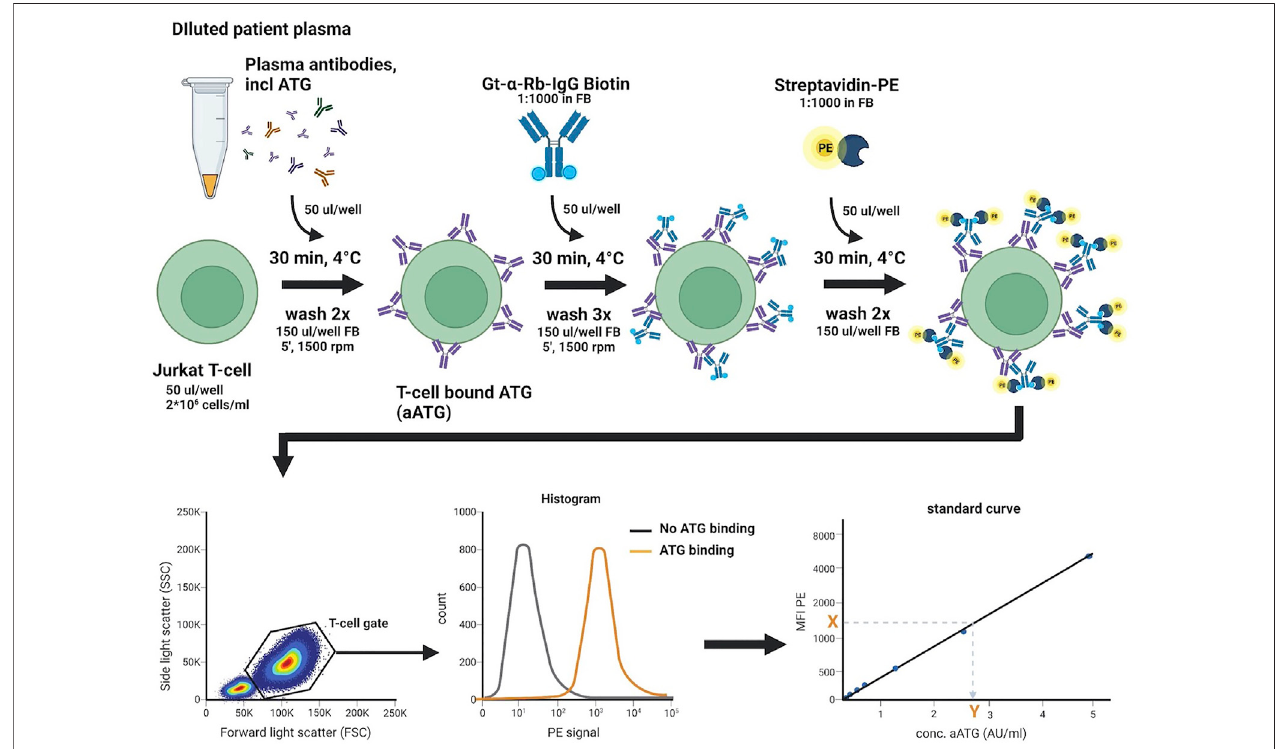
FIGURE3| ActiveATGbindingassay.Standardcurve,QC,negativecontrol,and4-and8-folddilutedpatientplasmasamplesareincubatedina96-wellU-bottom plate with target Jurkat T-cells, to allow for binding of aATG. Detection of bound aATG is done by subsequent incubation with a Gt- α -Rb-Ig-biotin antibody and streptavidin-PE. Cells are then analyzed on a FACS Canto II fl ow cytometer by acquiring 70 µl sample at a fl ow rate of 3 μ l/s and intermittent mixing, measuring 10.000 events within the live T-cell gate. The median fl uorescence intensity (MFI) of PE measured is then used to extrapolate the concentration of aATG (in AU/ml) in the patient sample from the standard curve. FB, FACS buffer (PBS/1%HSA). This fi gure was created with